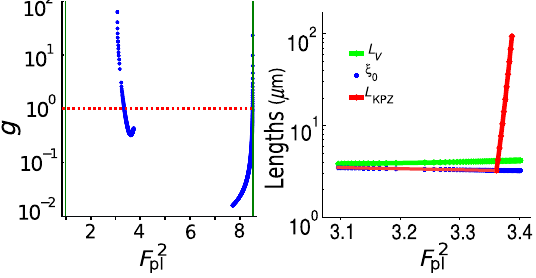
FIG. 6. Characteristic length scales in the WA regime at intermediate pump powers. Left panel: Nonlinear parameter g as a function of the pump strength normalized to the pump at the lower threshold for a stable three-mode OPO solution with zero detuning. The vertical green lines indicate the lower and upper mean-field thresholds, and the red dotted line marks the g ¼ 1 border. These are the stable solutions at intermediate values of F p (region B in Fig. 2). Right panel: Characteristic length scales at the intermediate F shown in the left panel. Healing length ξ 0 p (blue line), length scale for vortex-dominated disordered phase L (green line), and the KPZ length scale L (red line) as a v KPZ function of pump strength normalized to the pump at the upper threshold. Note that to the left of the nearly vertical increase of L , its value is indistinguishable from the healing KPZ